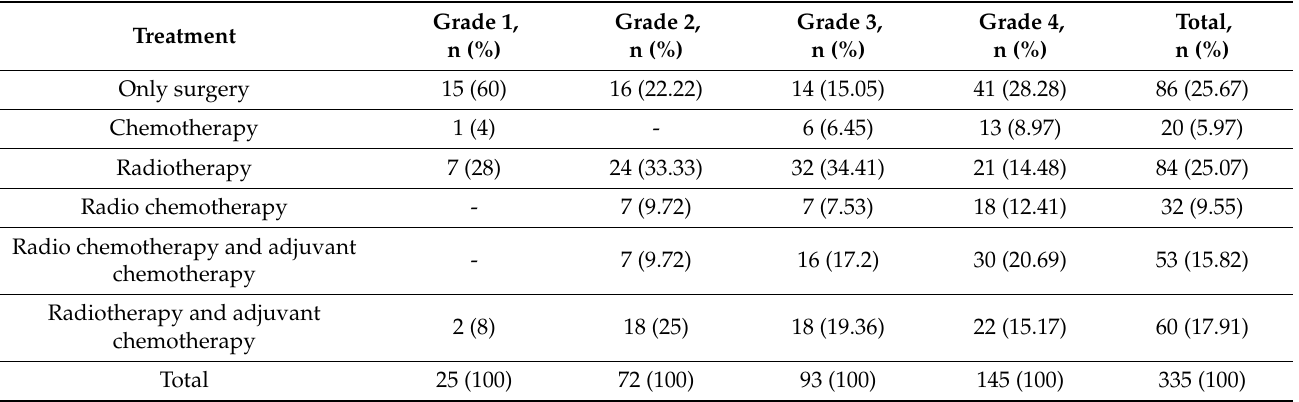
Table 4. Distribution of treatment methods by grades.